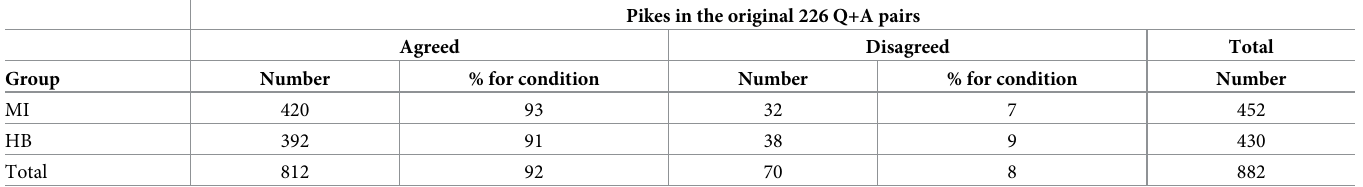
Table 1. Number and percentage of agreements and disagreements about pike location per condition (MI and HB) and overall (total) in the initial corpus. Pikes in the original 226 Q+A pairs Agreed Disagreed